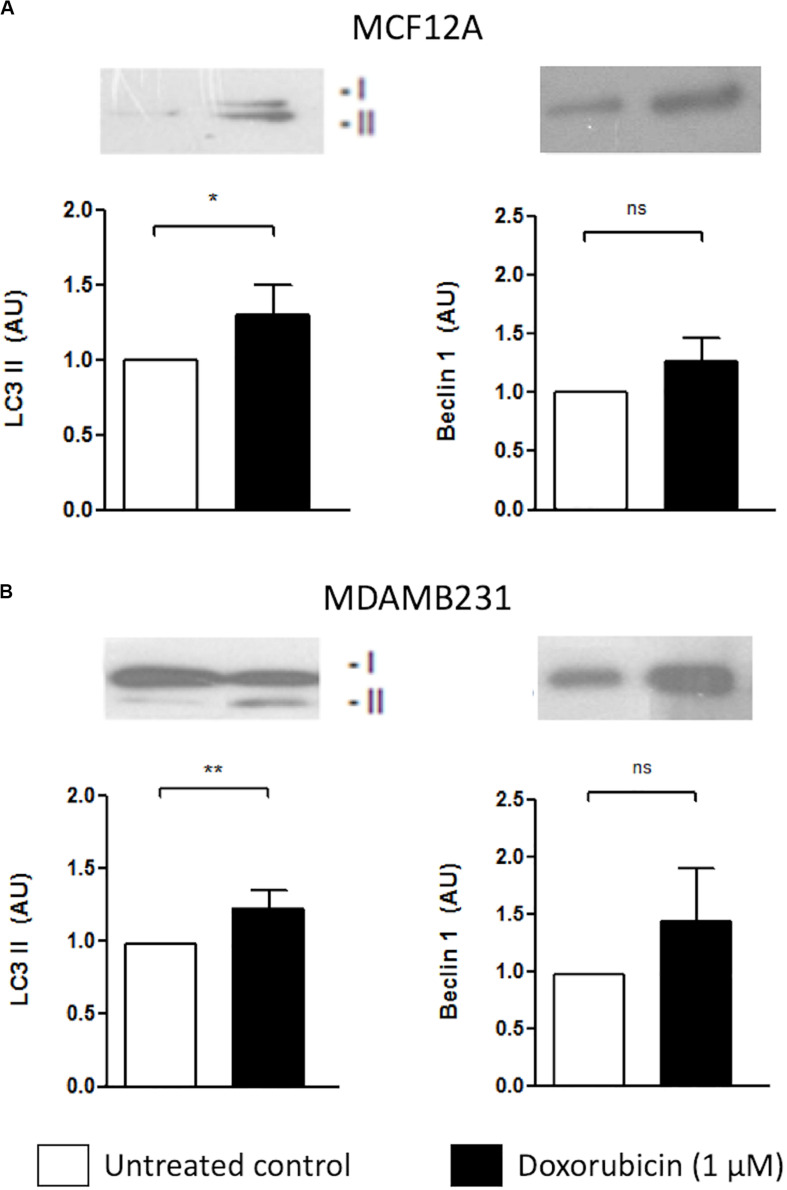
LC3 II and Beclin 1 protein levels in MCF12A and MDAMB231 cells treated with Dox. Representative western blots and bar graphs showing densitometric representation of LC3-II and Beclin-1 protein levels in MCF12A (A) and MDAMB231 (B) cells. Each value represents the mean ± SEM of at least three independent determinations. AU, arbitrary units; Con, control; *p < 0.05; **p < 0.01; ns, no significance.